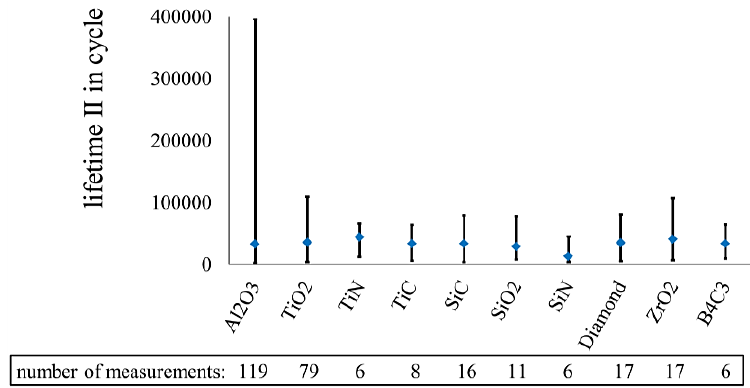
Figure 20. Effect of different nanoparticles on the lifetime of electrically conductive surfaces in fretting corrosion